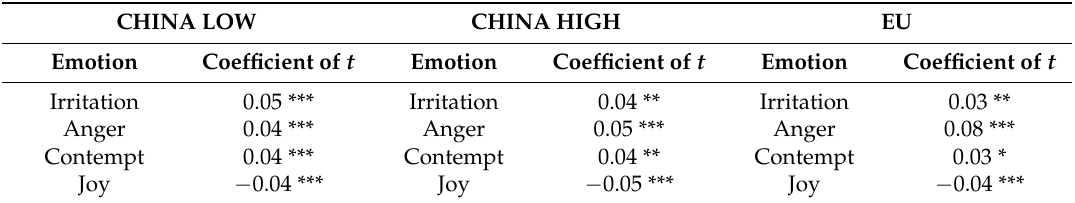
Table 4. Relation between the responders’ emotion intensity and the take rate. CHINA